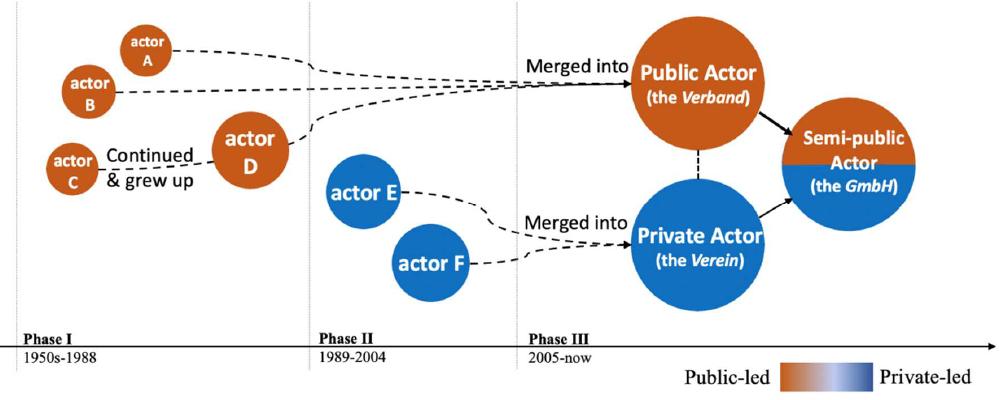
Figure 7. Changes in governance actors in MRN. Source: the authors.